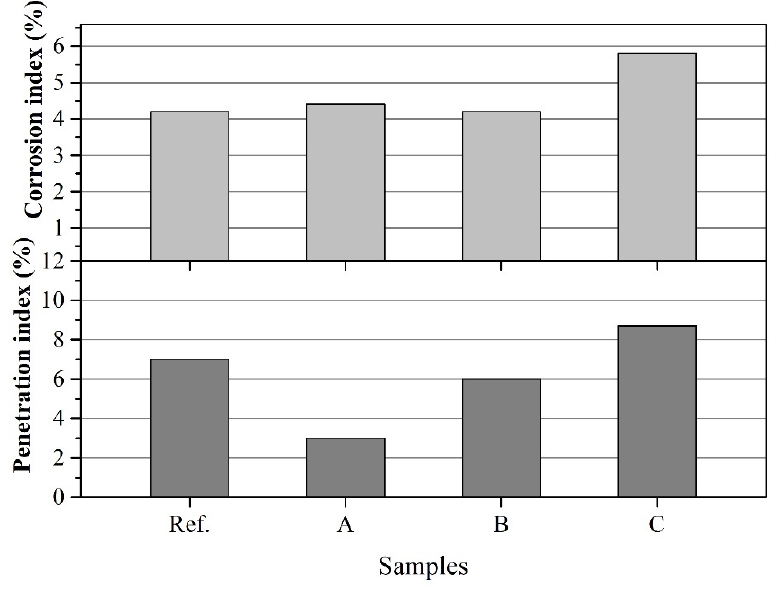
Figure 5. Corrosion and penetration index of corroded specimens after the corrosion test.